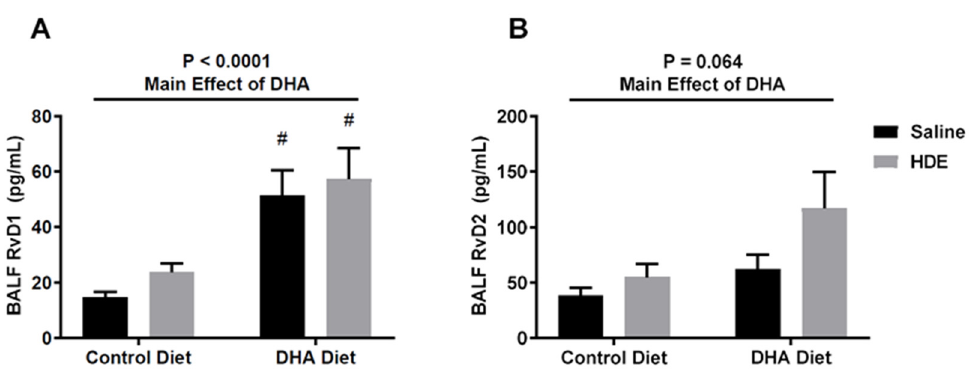
Figure 4. A high-DHA diet increases the production of Resolvin D1 in the lung following a single intranasal challenge with HDE. BALF levels of the specialized pro-resolving mediators (SPMs) Resolvin D1 (RvD1) ( A ) and Resolvin D2 (RvD2) ( B ) were assessed via ELISA following euthanasia. The main significance bars and p -values on the top represent the main effects of DHA on SPM production. Tukey post hoc comparisons for significant differences between the DHA- and control- diet-treated conditions are depicted by the # symbol (# p <